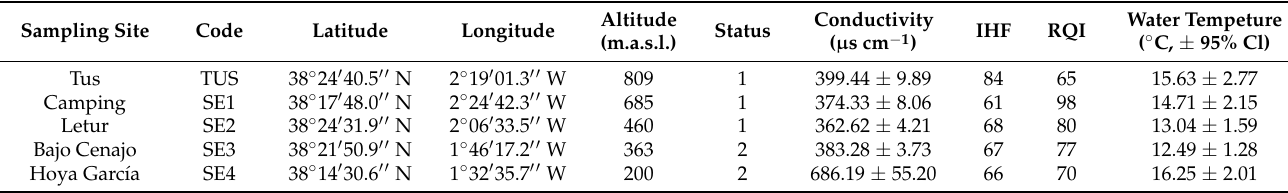
Table 1. Habitat variable values of each sampling site where Gobio lozanoi populations were assessed in the Segura River Basin. Sampling